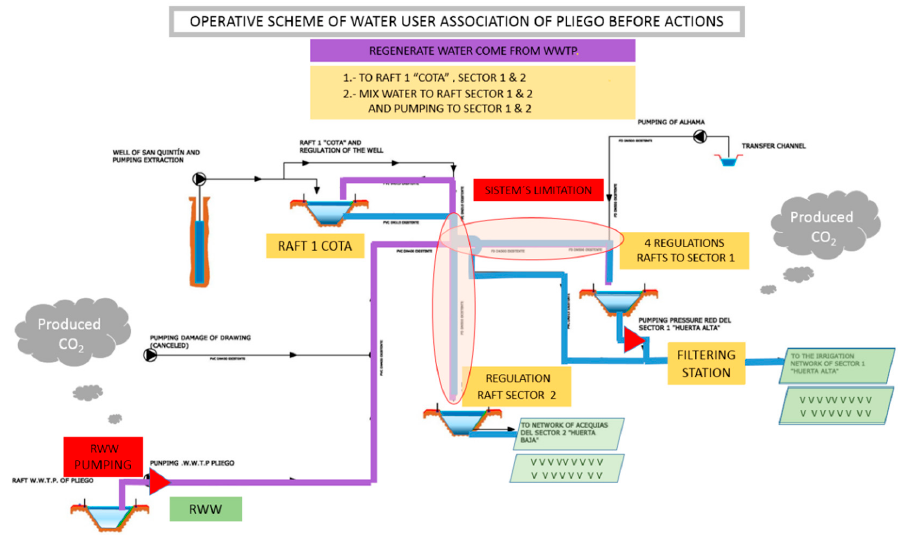
Figure 14. Operative scheme of WUA of Pliego before actions.